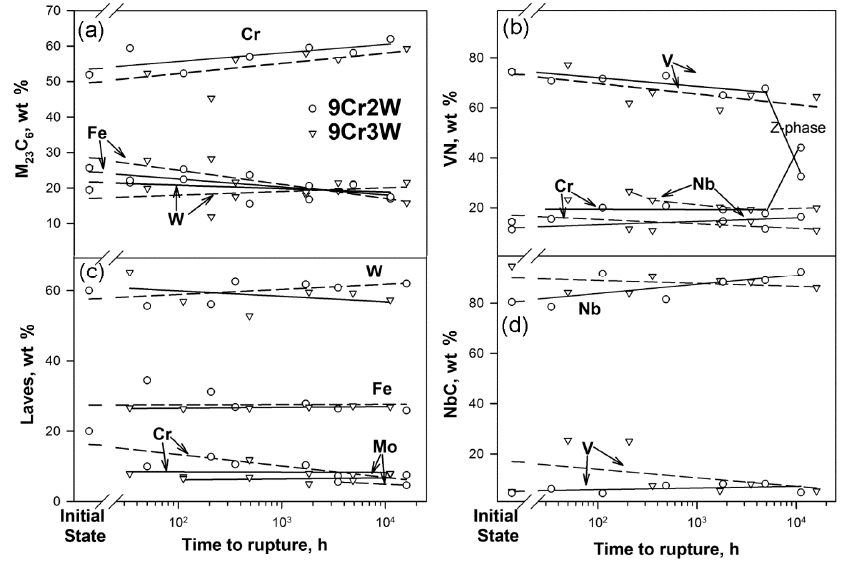
Figure 7. Change in the chemical compositions of ( a ) М 23 С 6 carbides; ( b ) V-rich MX; ( c ) Laves phase particles; and ( d ) Nb-rich MX during creep tests at 650 °C under the stresses of 100–220 MPa.